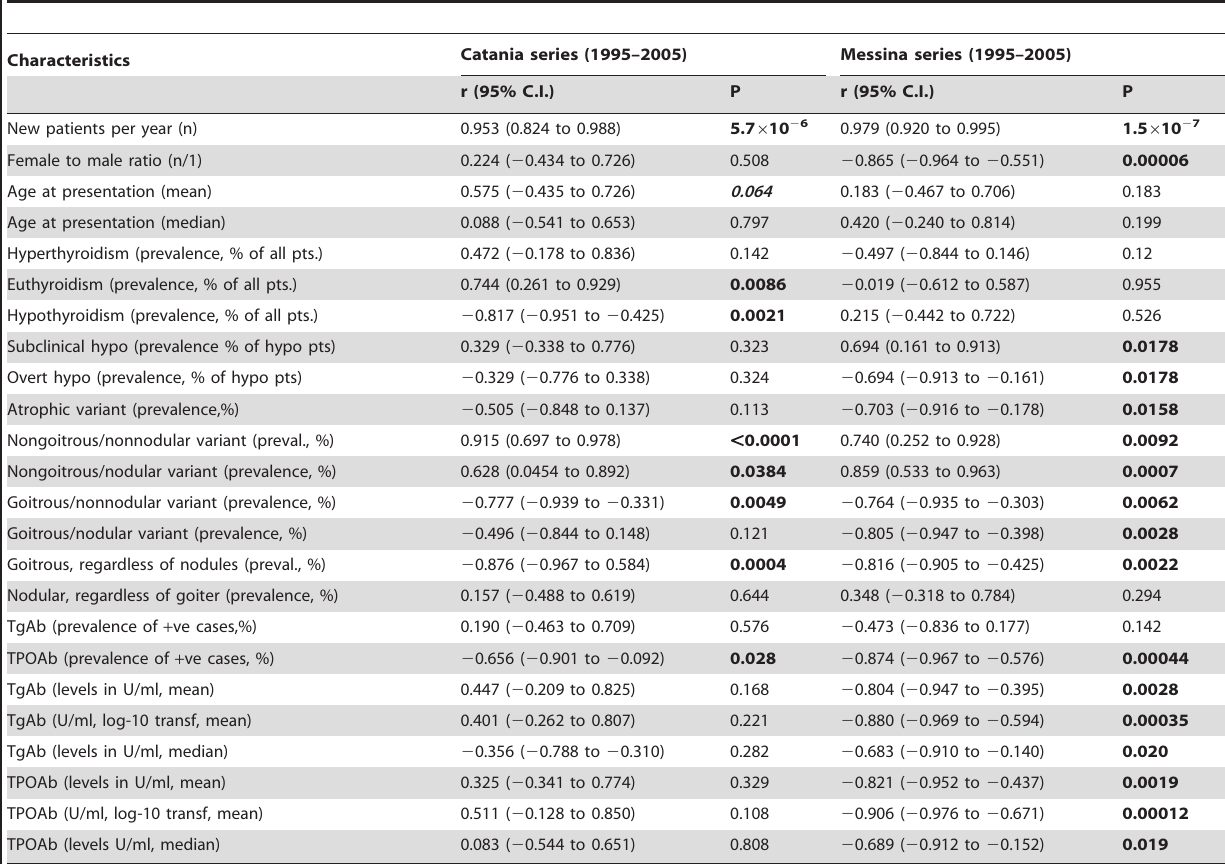
Table 2. Summary of the relationships between the calendar year (1995–2005) and the indicated characteristic in the Catania or the Messina cohort of Hashimoto’s thyroiditis (HT) patients.